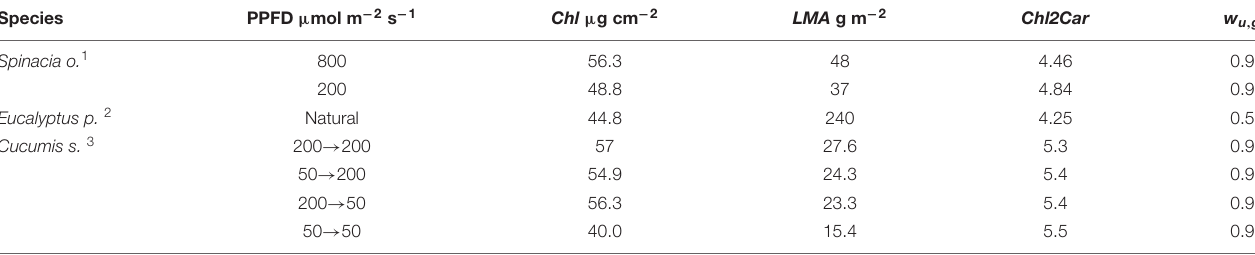
1 Nishio et al. (1993); 2 Evans and Vogelmann (2006); 3 Trouwborst et al. (2011b). Chl, chlorophyll a + b; LMA, Leaf mass area; Chl2Car, chlorophyll to carotenoid ratio; w u , g , fractional light interception at upper leaf side.